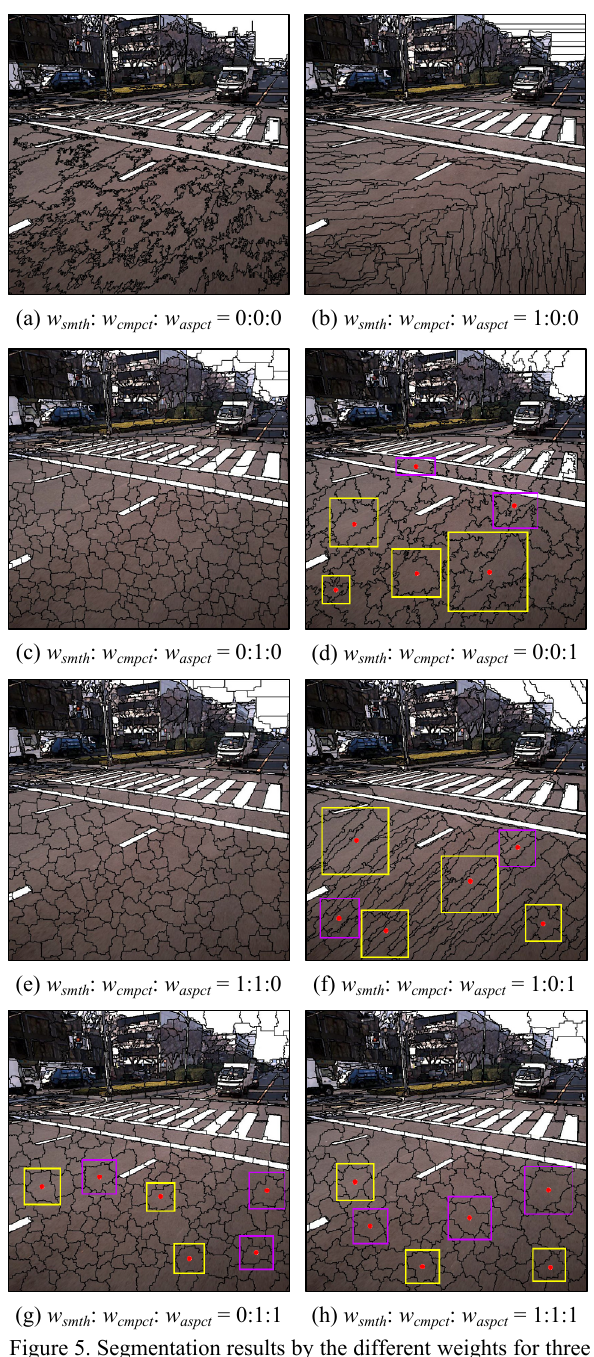
Figure 5. Segmentation results by the different weights for three shape